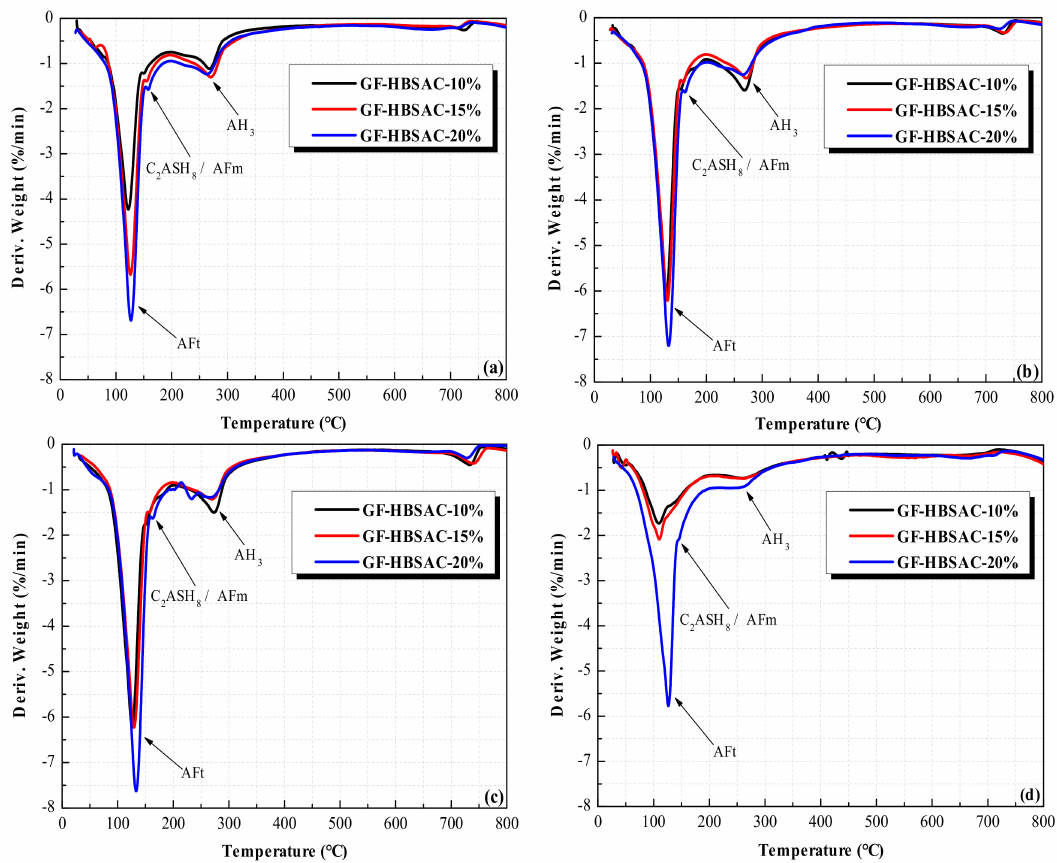
Figure 23. DTG curves of the Series GF-HBSAC-Y cement hydration products at di ff erent curing ages: ( a ) One day; ( b ) 3 days; ( c ) 7 days; ( d ) 28